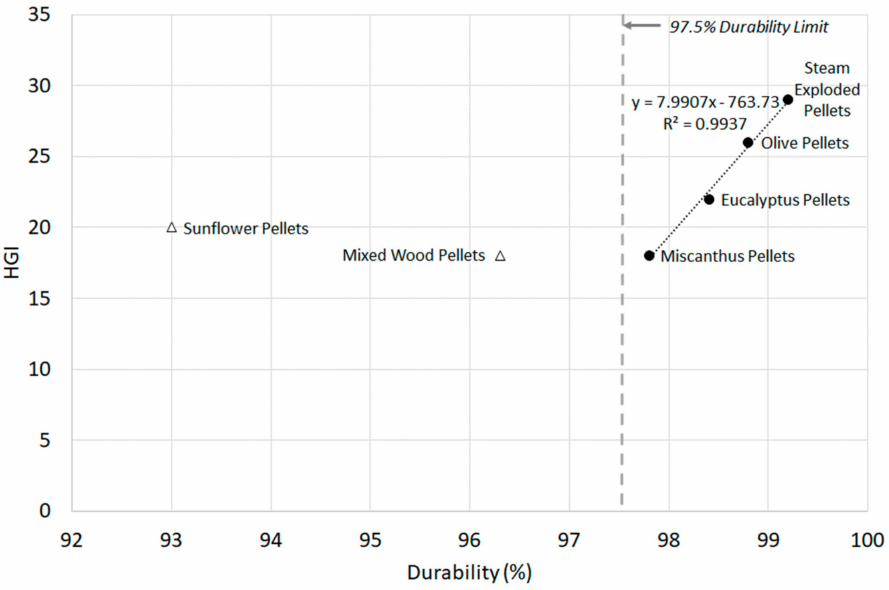
Figure 4. Pellet Hardgrove Grindability Index (HGI) values versus pellet durability. The acceptable limits of durability according to BS EN ISO 17225-2/6 for wood and non-wood pellets are noted ( n =